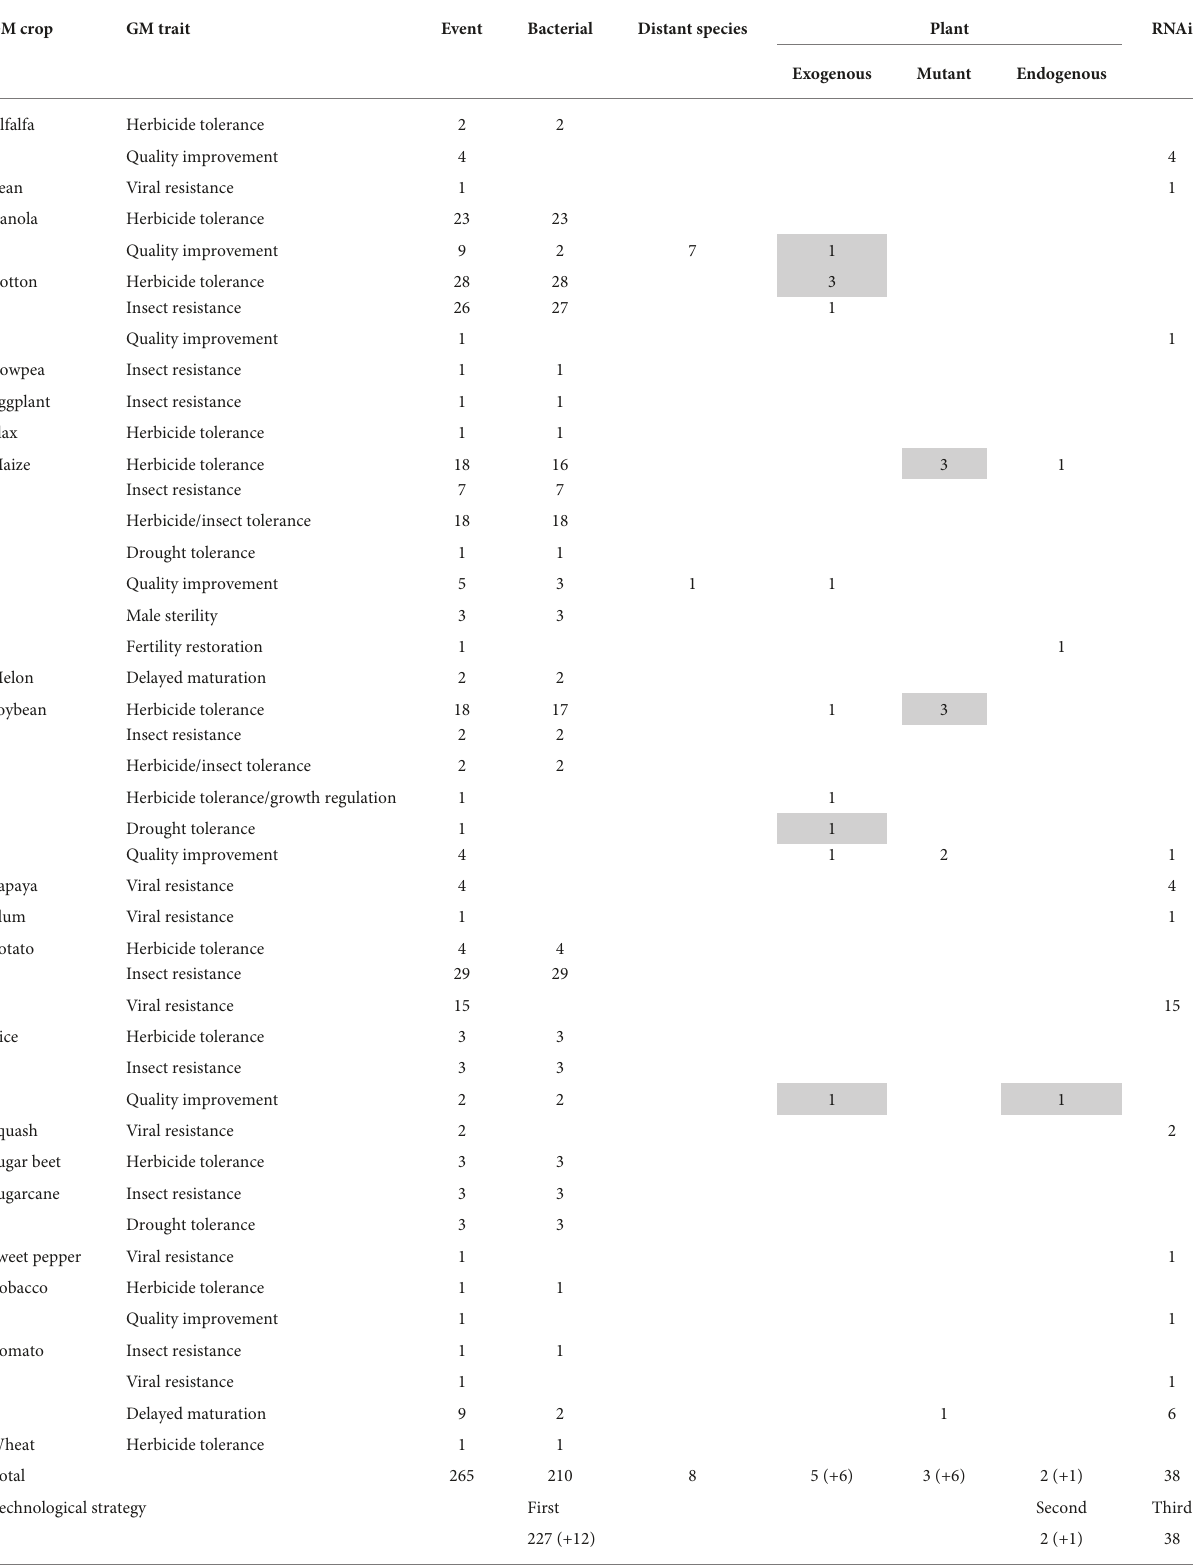
TABLE 1 Singular transgenic events approved for commercial